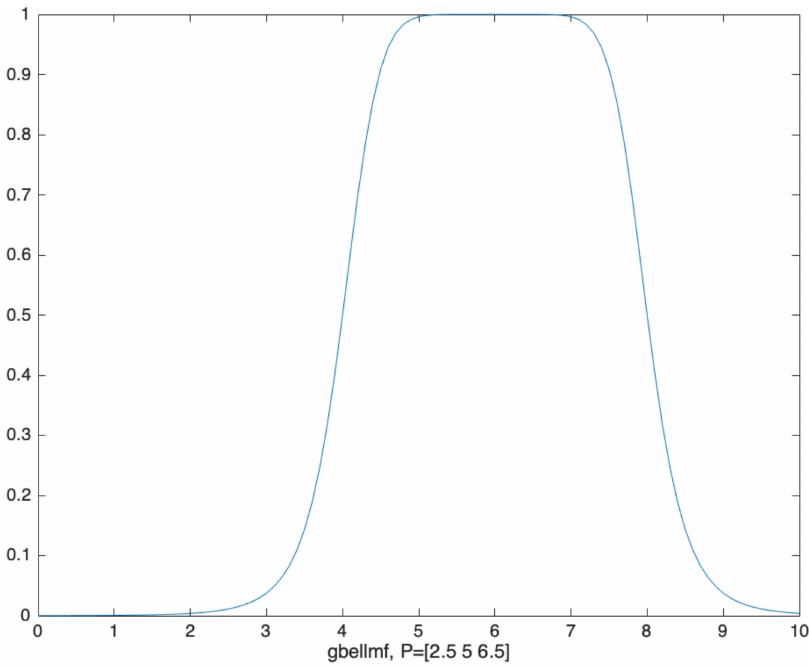
Figure 6. A typical graph of gbellmf (parameters [a, b, and c] respectively equals [2.5, 5, and